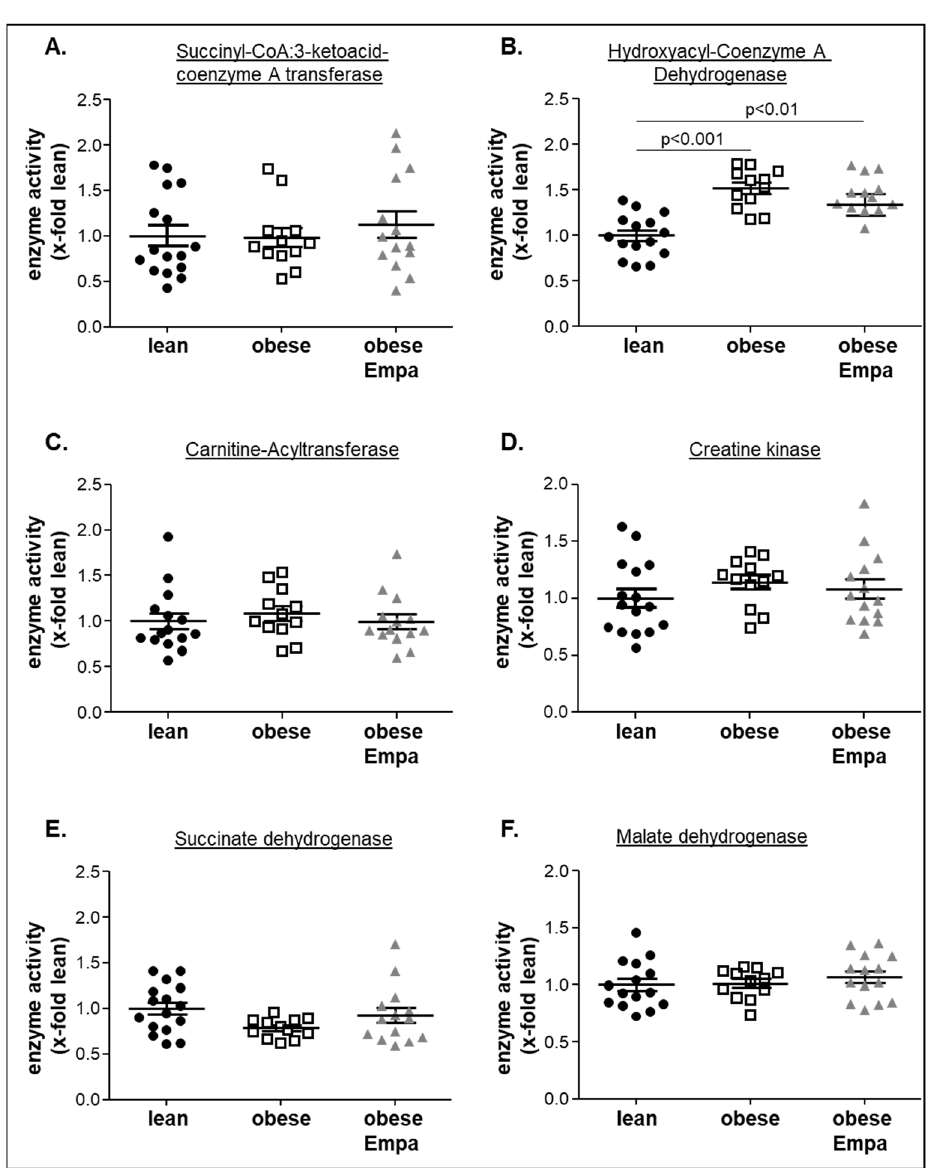
Figure 7. Enzyme activities of succinyl-CoA:3-ketoacid-coenzyme A transferase ( A ), hydroxyacyl- Coenzyme A dehydrogenase ( B ), carnitine-acyltransferase ( C ), creatine kinase ( D ), succinate dehy- drogenase ( E ), and malate dehydrogenase ( F ) were measured in soleus muscle homogenates from ZSF1-lean (lean, black circles), ZSF1-obese (obese, open squares) and ZSF1-obese rats treated with Empagliflozin (obese + Empa). Results are expressed as mean ± SEM ( n = 12–15 per group).